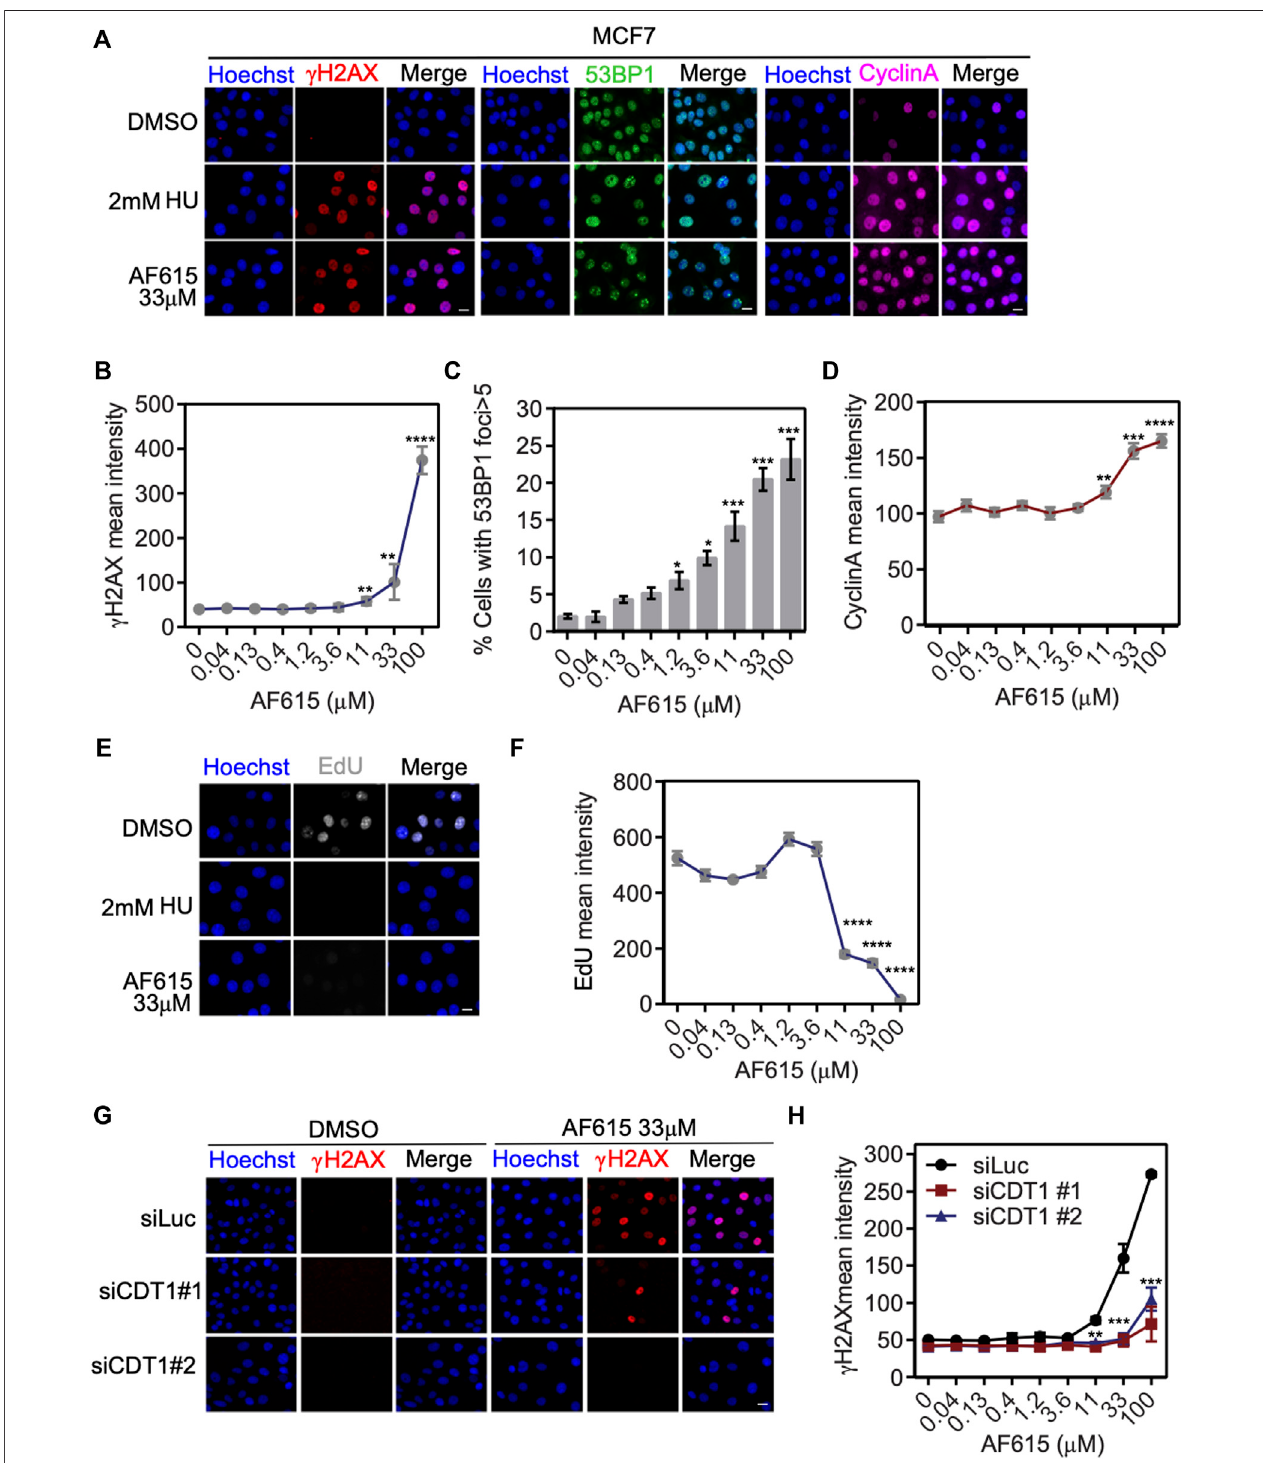
FIGURE 3 | Compound AF615 induces DNA damage and blocks DNA synthesis in cancer cells. (A) Representative images of MCF7 cells treated with 33 μ M compoundAF615for24 handimmunostainedfor γ H2A Χ ,53BP1andCyclinA.NucleiwerecounterstainedwithHoechst.Control,2 mMHU(Hydroxyurea)for24 h. (B) Quantitative analysis of γ H2A Χ mean intensity using high-content imaging and high-throughput automated image analysis. Graph depicts the mean γ H2A Χ intensity of n = 3 biological independent experiments per compound AF615 concentration. (C) Quanti fi cation of the percentage of cells with 53BP1 foci ( > 5 foci per nucleus) per compoundAF615concentration.Graphdepictsthemean%percentage ofcellswith53BP1 fociof n =3biologicalindependentexperimentspercompound AF615